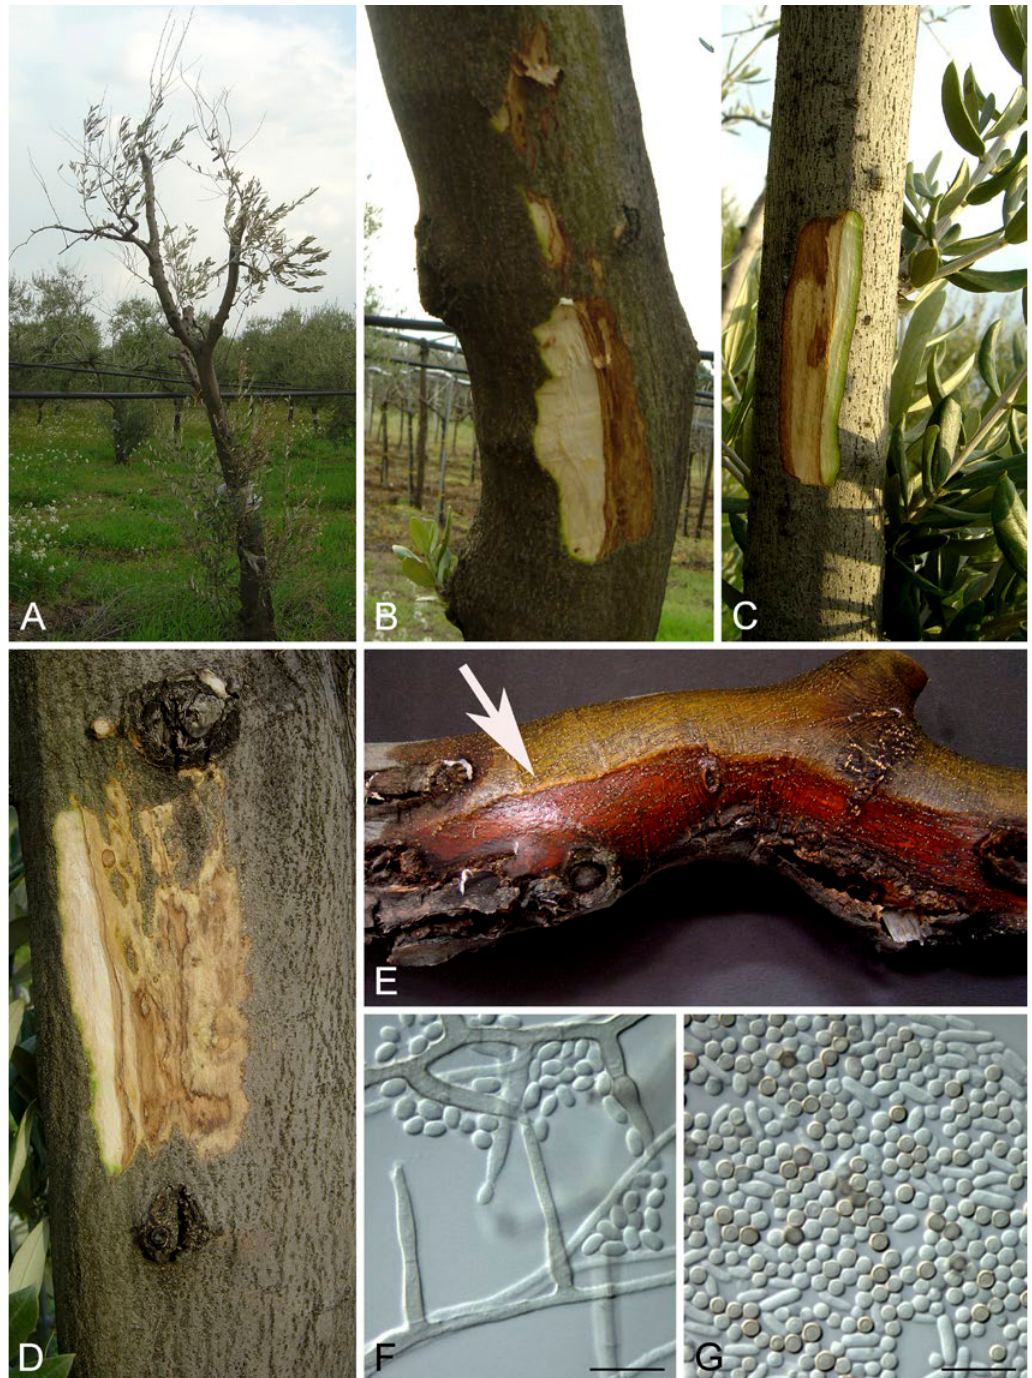
Figure 1. Disease symptoms observed on olive trees. (a) Wilt and die-back. (b–d) Sub-cortical browning as longitudinal streaking from young (12 years old) and adult (26 years old) trees. (e) Cankers and brown streaking on branches. White arrow, region from which Pl. richardsiae was frequently isolated. (f, g) Microscopic features of Pl. richardsiae . (f) Conidi- ophores and conidiogenous cells. (g) Brown, globose, and hyaline, cylindrical conidia. Scale bar in f, g = 10